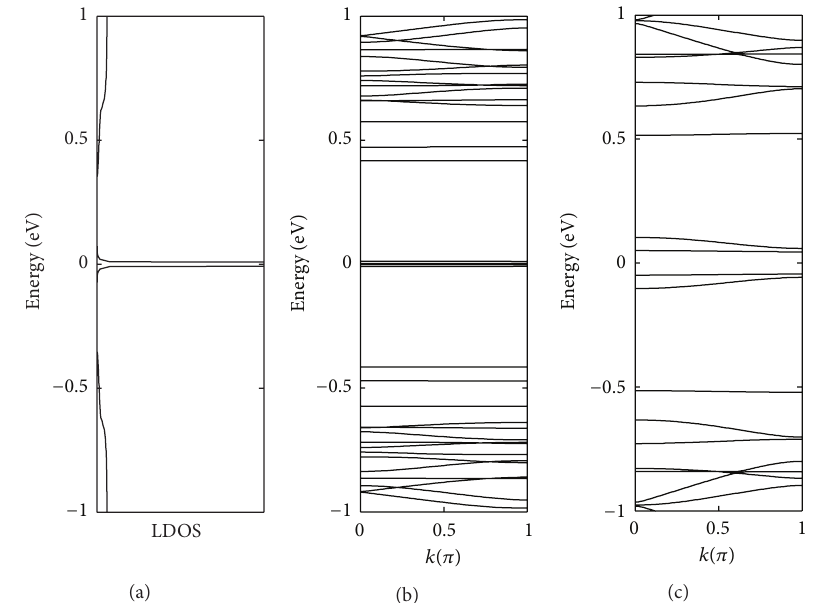
Figure 2: (a) LDOS at the wedge for the single junction (8,0)/(14,0). (b) Band structure of the 12(8,0)/12(14,0) SL. (c) Band structure of the 5(8,0)/5(14,0)